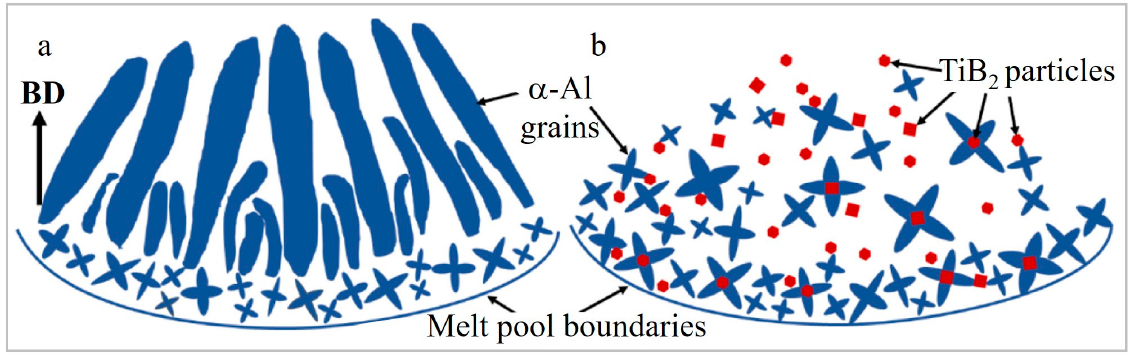
Figure 4. Graphical illustration of grain formation during solidification in a melting pool of AlSi10Mg ( a ) and AlSi10Mg-TiB 2 AMC ( b ) (reproduced with permission from [77]). ( a ) and AlSi10Mg-TiB 2 AMC ( b ) (reproduced with permission from